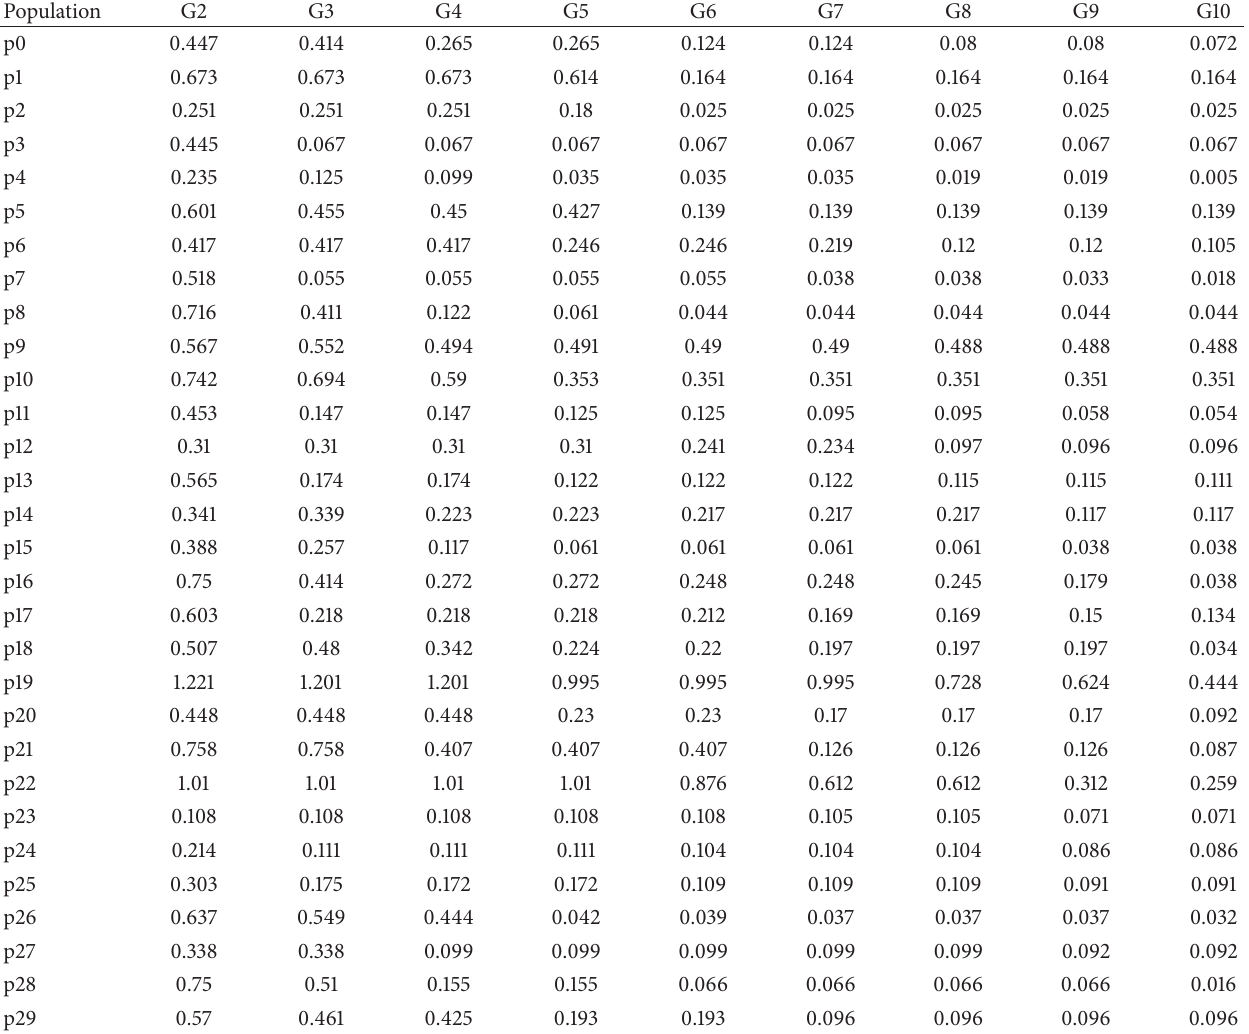
Table 4: Errors obtained from the evolution of 30 populations composed of 25 individuals in Cap de Creus